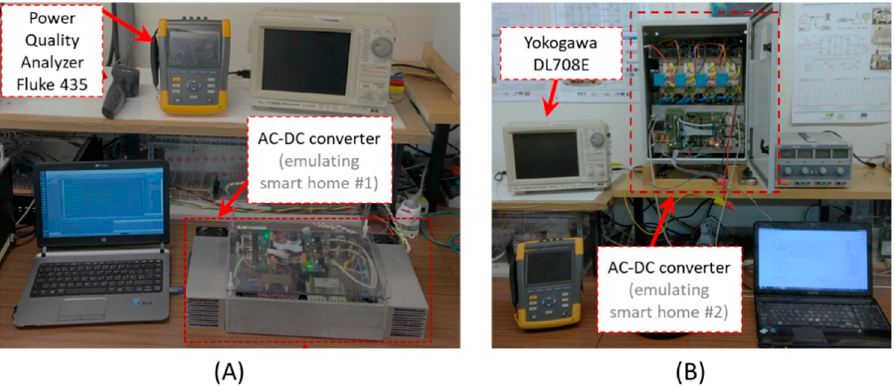
Figure 6. Workbench showing the front-end AC/DC converters for emulating the two smart homes: ( A ) Prototype with the multi-level AC/DC converter; ( B ) Prototype with the full-bridge AC/DC con- verter.